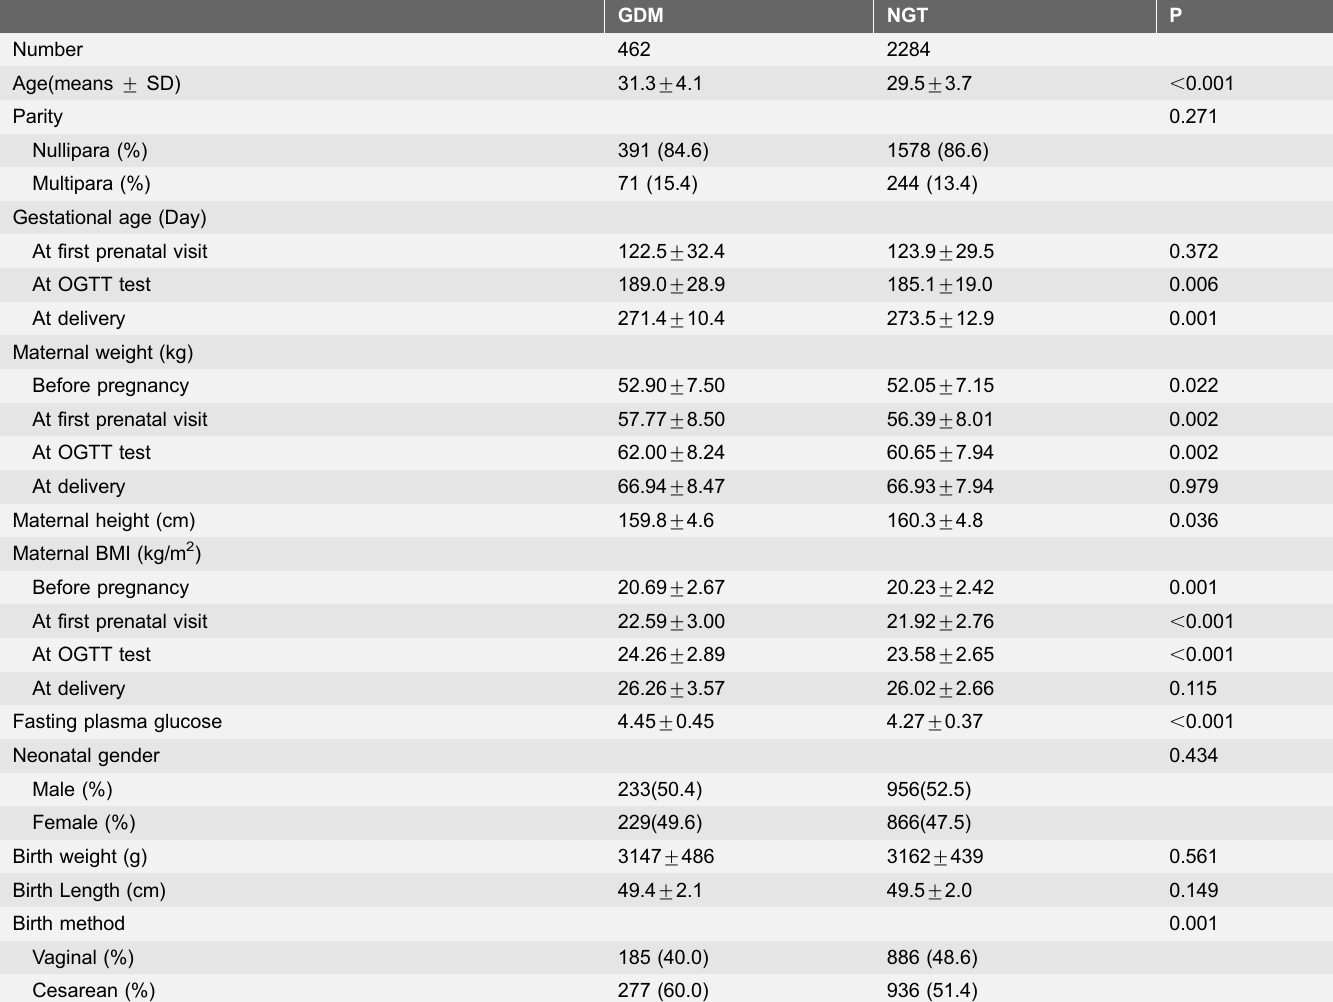
Table 1. Baseline characteristics of the research